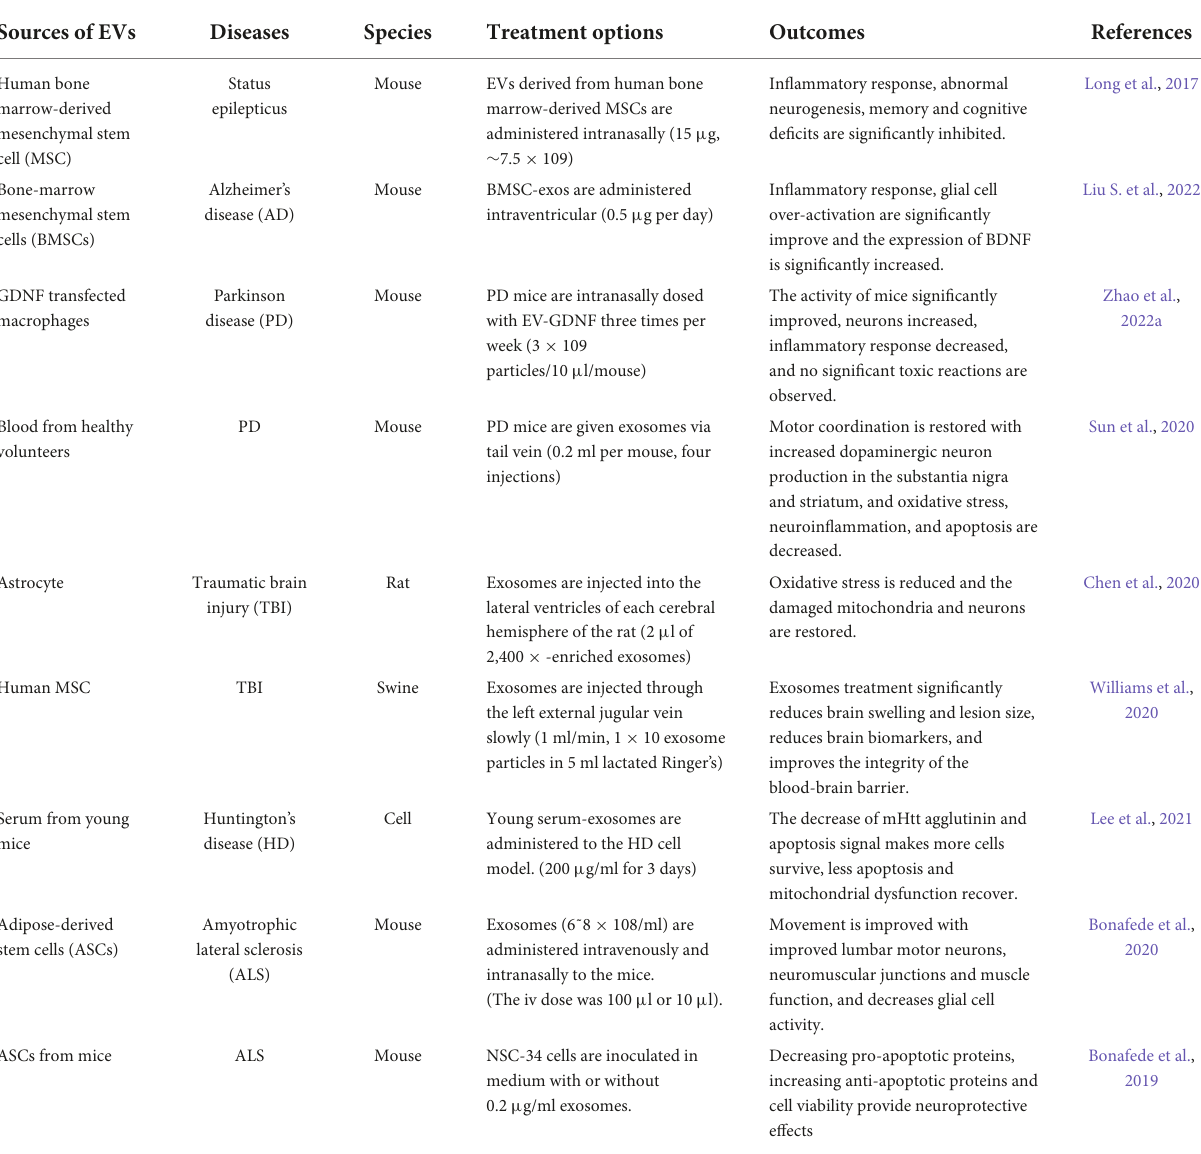
TABLE 1 Clinical treatment of EVs in the neurodegenerative